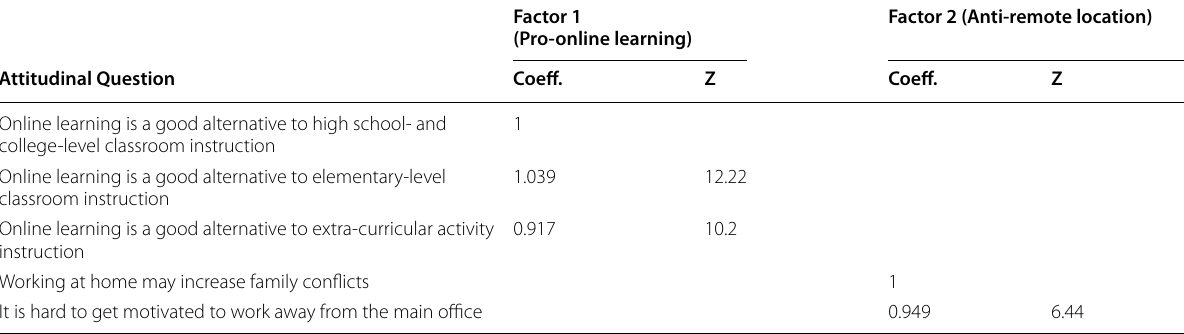
Factor 1 Factor 2 (Anti-remote location) (Pro-online learning)